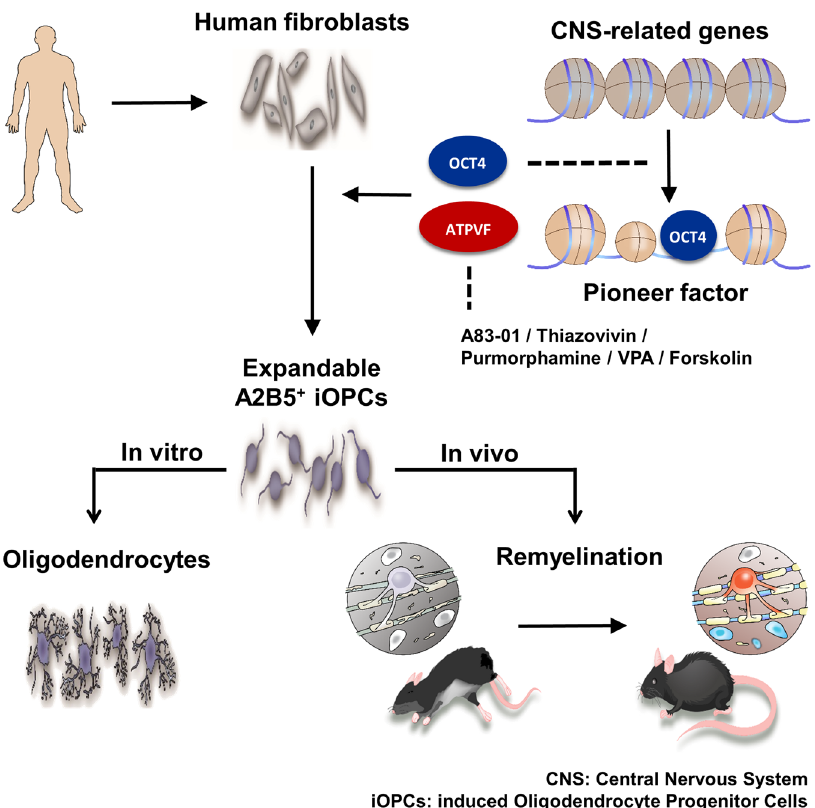
Fig. 7 Schematic summary of the present study. This study describes the role of OCT4 in combination with de fi ned small molecules for direct reprogramming of human somatic cells into oligodendrocyte progenitor cells (OPCs). The expandable and transplantable induced OPCs (iOPCs) promoted remyelination in shiverer mice with hypomyelination and rescued the disease phenotype in a mouse model of multiple